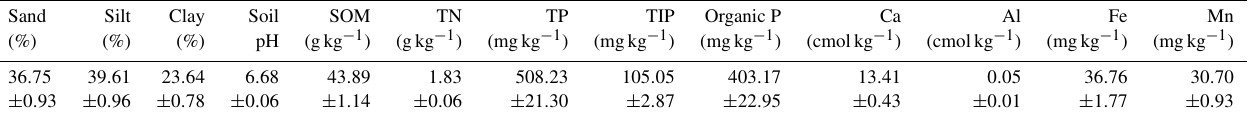
Table 1. General characteristics of the soil from the experimental site before nitrogen and phosphorus manipulation. Selected parameters in- clude sand, silt, and clay fractions; soil pH; soil organic matter (SOM); total nitrogen (TN); total phosphorus (TP); total inorganic phosphorus (TIP); organic P; exchangeable Ca and Al; and available Fe and Mn. Data are mean ± standard error ( n =